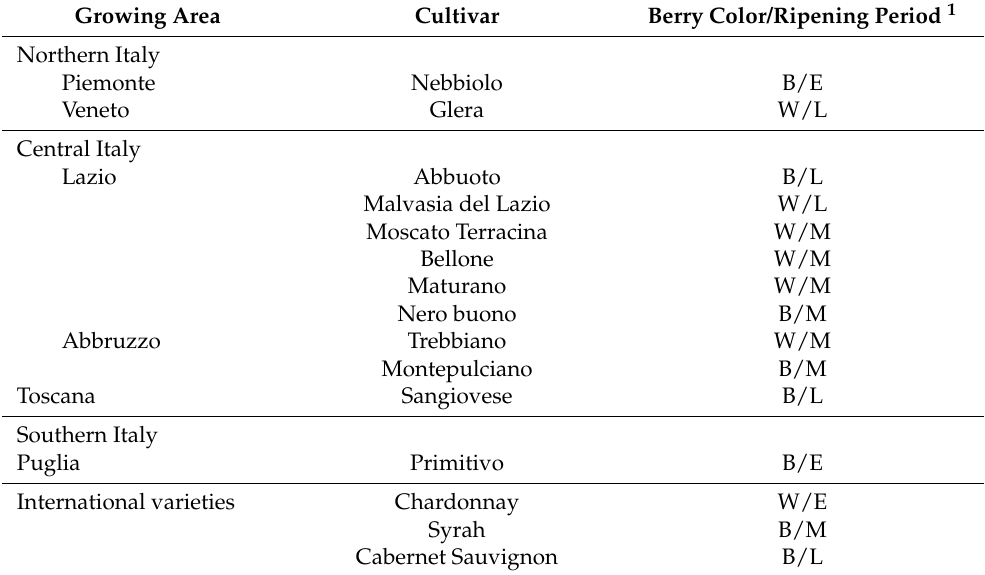
Table 2. Selected grapevine varieties grouped by geographical provenience, berry color, and ripening